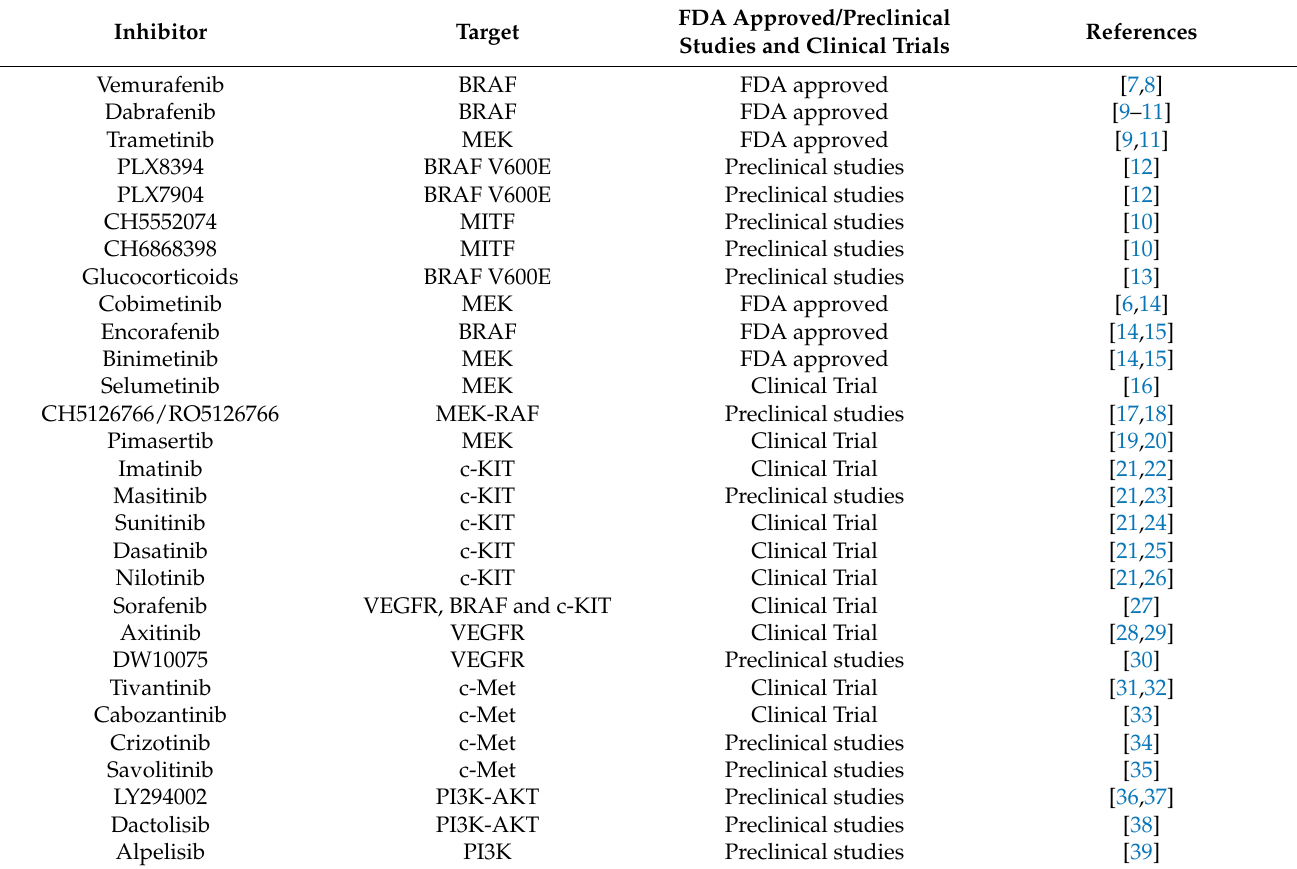
Table 1. Current molecularly targeted therapies, their associated targets, and their clinical status. Targets include B-Raf serine/threonine kinase (BRAF), mitogen-activated protein kinase (MEK), microphthalmia-associated transcription factor (MITF), receptor-tyrosine kinase MET (c-Met), receptor-tyrosine kinase Kit (c-KIT), vascular endothelial growth factor receptor (VEGFR), and phosphoinositide-3-kinase AKT signaling pathway